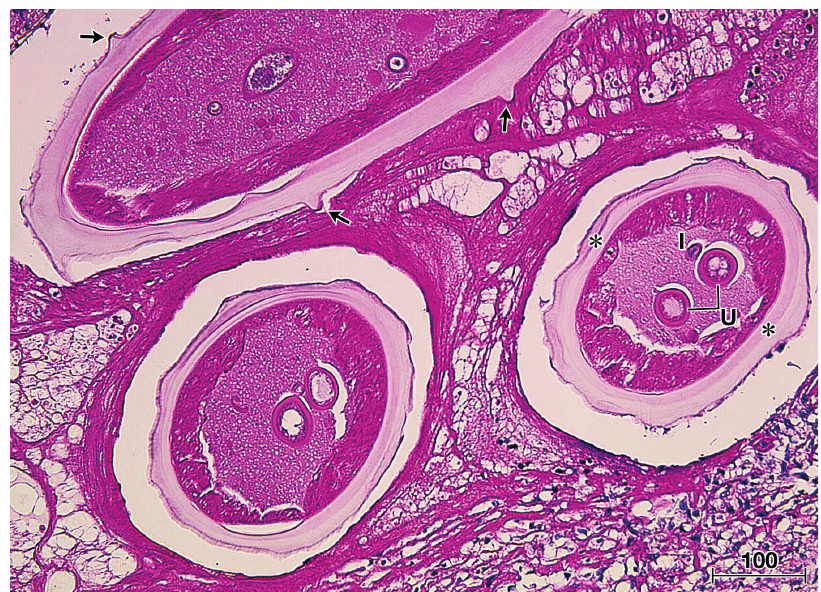
Fig. 1. – Histological section of a nodule showing the worm and surrounding tissue excised from the